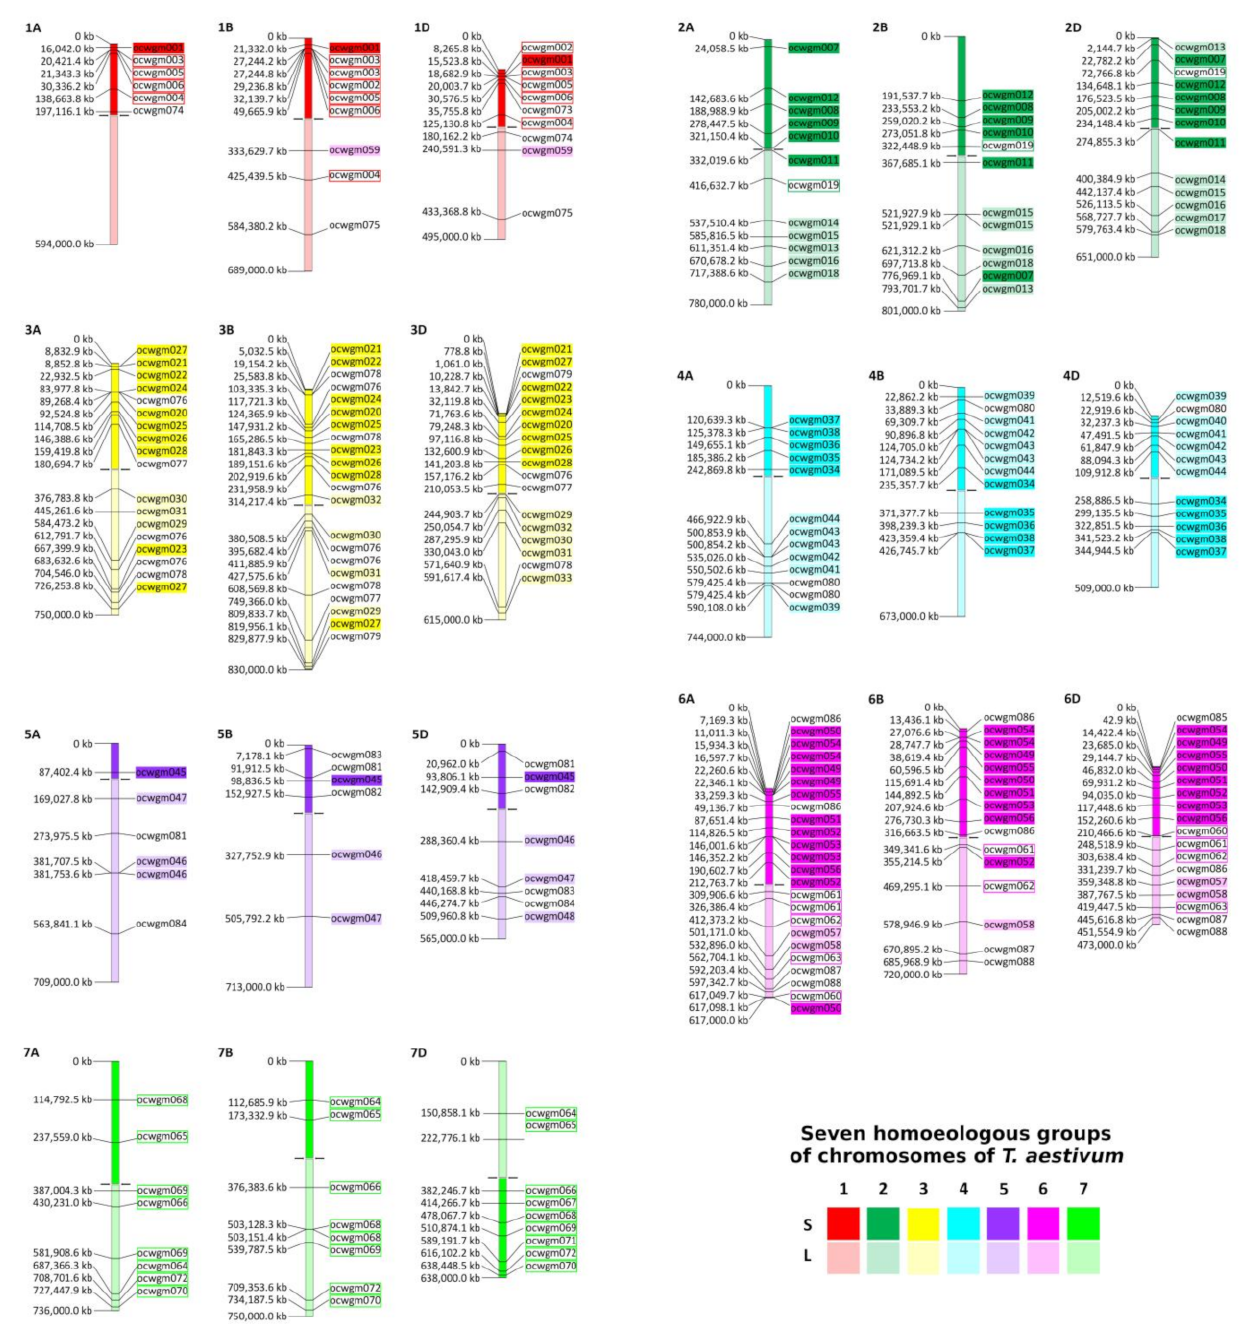
Figure 3. Position of the new Agropyron -specific SSR markers on collinear chromosomes of T. aestivum . Seven homoeologous groups of wheat chromosomes are differentiated by colors (red, green, yellow, turquoise, purple, pink and light green). Short chromosomal arms (S) are dark in color, and long chromosomal arms (L) are light in color. Chromosome-specific SSR markers are marked by frames. Chromosome-arm-specific SSR markers are marked by frames filled up by colors of the corresponding chromosome arms. Any specific highlighting is not used for SSR markers localized in multiple positions in the genome of A. cristatum . Arrows depict positions of centromeres, as observed by Appels et al.